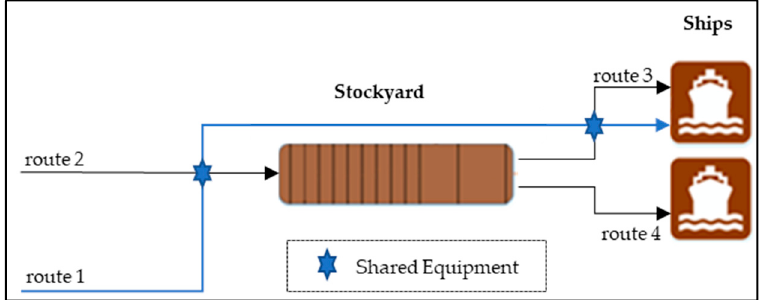
Figure 3. Equipment shared between routes 1 and 2 and 1 and 3.